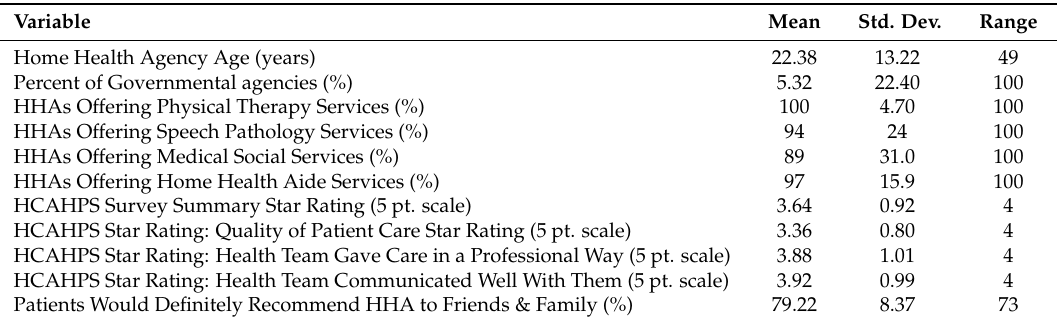
Table 1. Characteristics of Home Health Agencies and Health Consumer Assessment of Healthcare Providers and Systems (HCAHPS) Star Ratings.